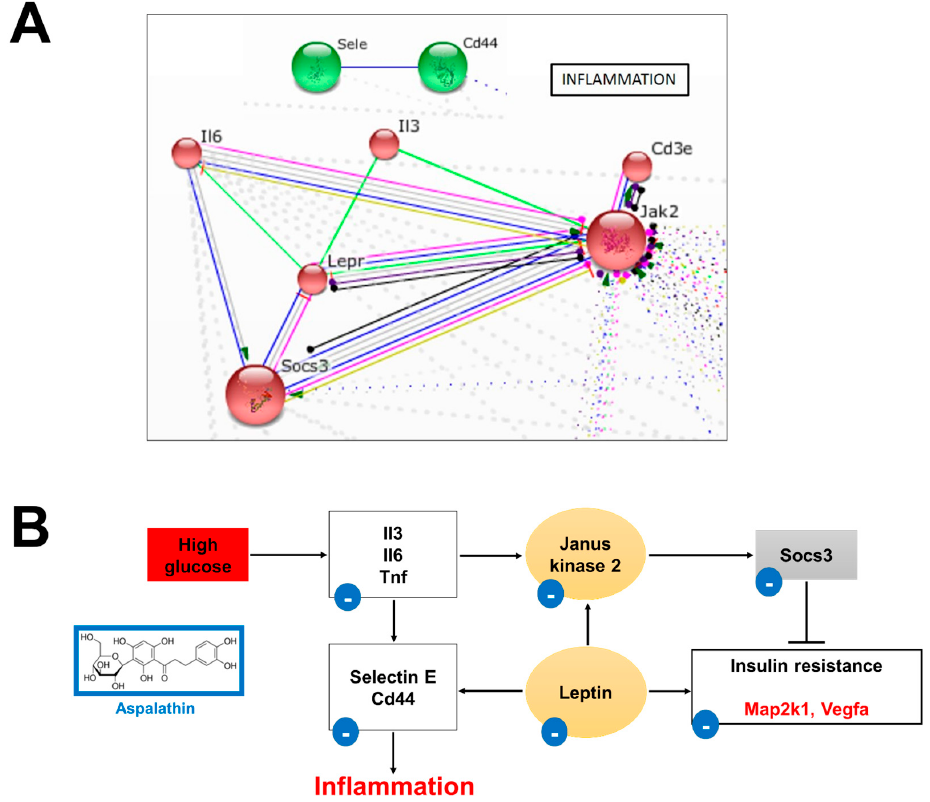
Figure 3. Aspalathin prevented high glucose-induced inflammation. ( A ) STRING database analysis confirmed a strong interaction between aspalathin treatment and genes associated with inflammation; ( B ) Representative diagram of the proposed protective mechanism of aspalathin against high glucose induced inflammation. Cd44 : cluster of differentiation 44; Il3 : interleukin 3; Il6: interleukin 6; Map2k1 : mitogen-activated protein kinase kinase 1; Socs3 : suppressor of cytokine signaling 3; Tnf : tumor necrosis factor; Vegfa : vascular endothelial growth factor A.